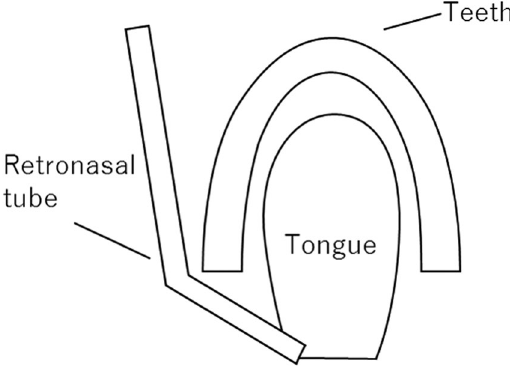
Figure 3. Illustration of placement of tube for retronasal